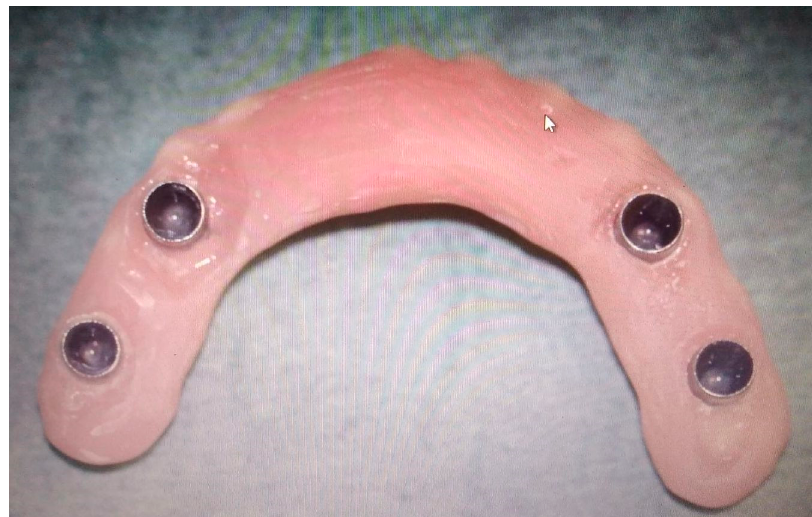
Figure 13. The removable prosthesis with morse-taper connection to the abutments of the mandibular prosthesis.